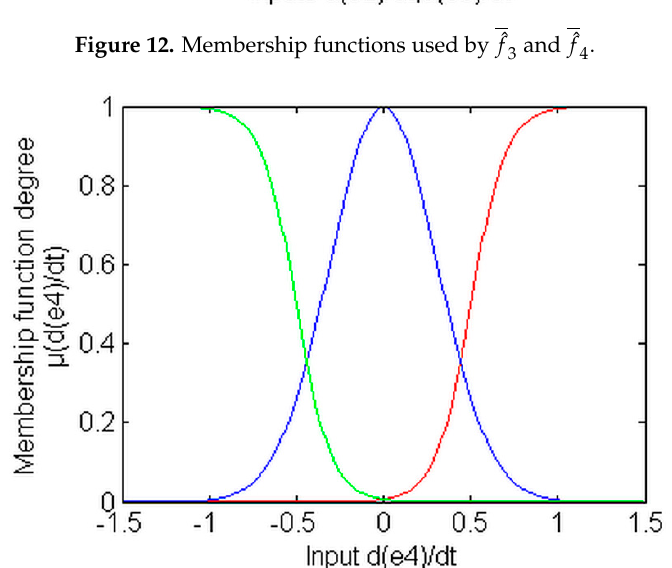
ˆ f ˆ f . Figure 13. Membership functions used by 2 ˆ f . ˆ f .